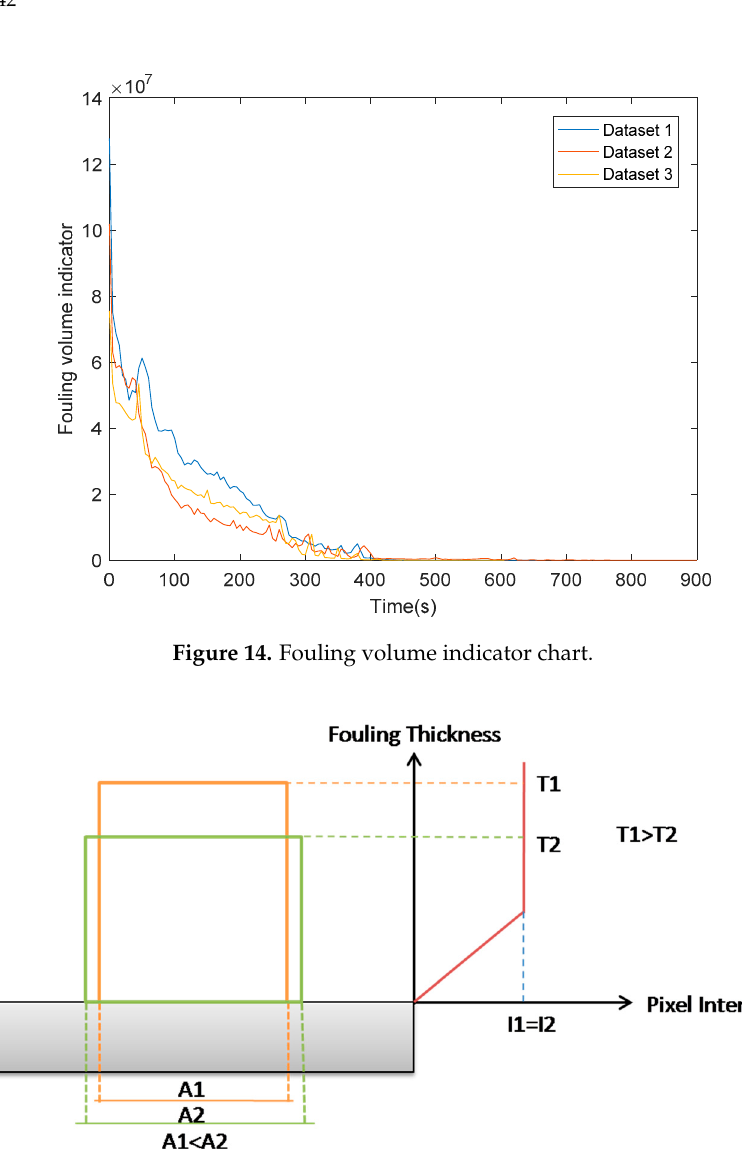
Figure 15. Pixel intensity vs. fouling thickness diagram.